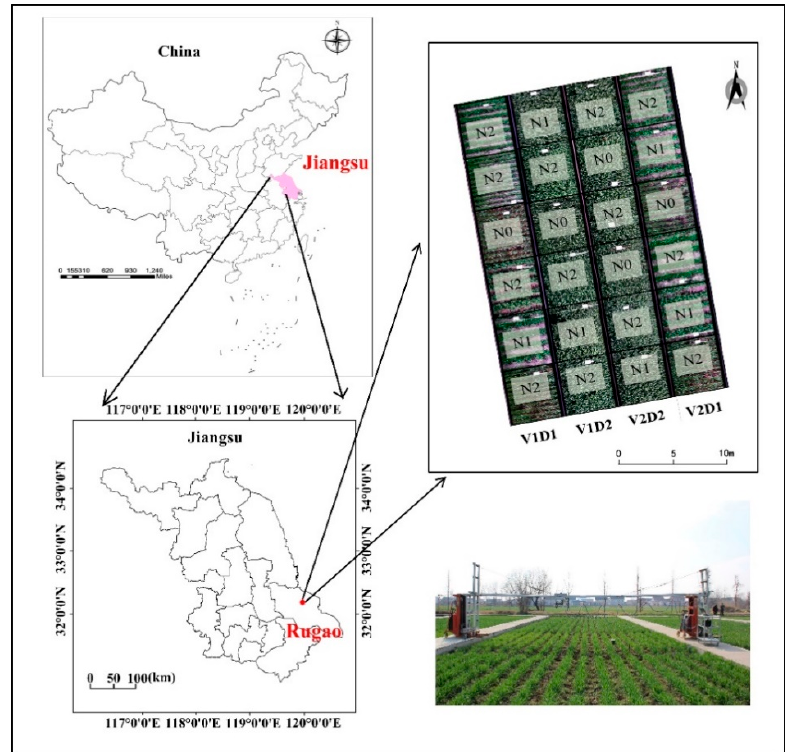
Figure 1. Location of the study area and hyperspectral imaging system. Note: D1 = 300 plants·m − 2 , D2 = 450 plants·m − 2 , N0 = 0 kg·N·ha − 1 , N1 = 150 kg·N·ha − 1 , N2 = 300 kg·N·ha − 1 , V1 = ‘ Yangmai 18’ , D2 = 450 plants · m − 2 , N0 = 0 kg · N · ha − 1 , N1 = 150 kg · N · ha − 1 , N2 = 300 kg · N · ha − 1 , V1 = ‘Yangmai V2 = ‘ Shengxuan 6’ . 18’, V2 = ‘Shengxuan